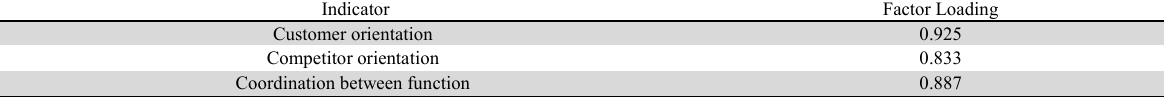
Factor Loading Results of Market Orientation Variable